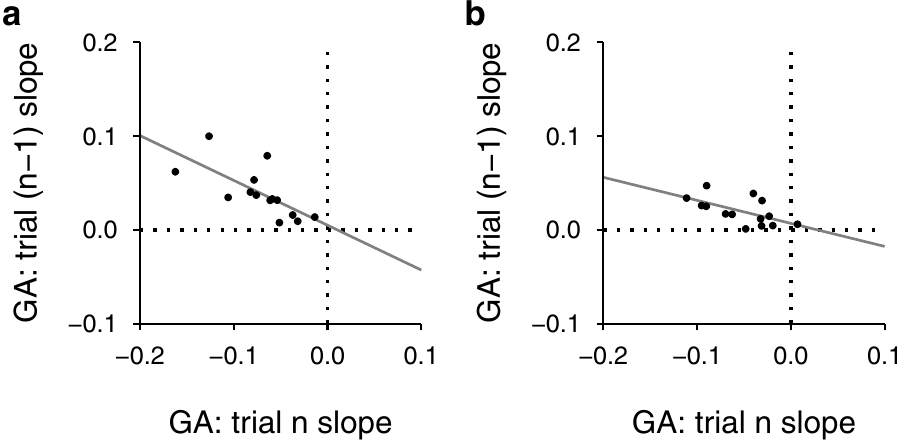
Figure 4. Relationship between individual current and previous distance effects on grip aperture. ( a ) Individual data from Experiment 1 (grasping along the object’s depth axis). ( b ) Individual data from Experiment 2 (grasping along the object’s oblique axis). Solid lines show the linear regression fits.